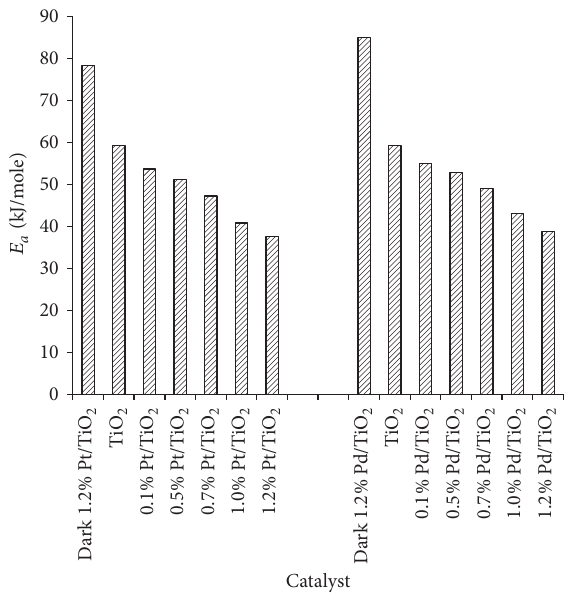
Figure 5: Plot for the correlation of activation energy and Pt or Pd content of photocatalyst. Reaction conditions : toluene: 20 mL, temp: 303–333 K, cat: 100 mg, irradiance: 3 hrs, flow: 40mL/min, pO 2 : 760 torr, and stirring: 850 rpm.